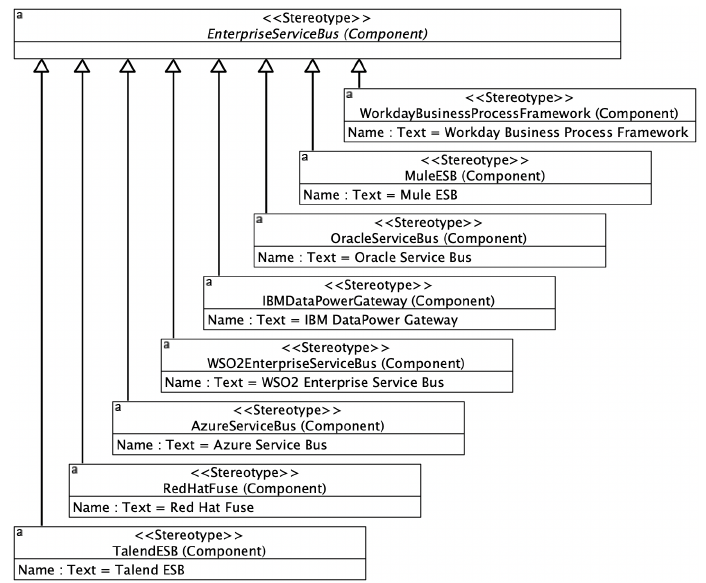
Figure 4. Stereotypes for enterprise service buses.